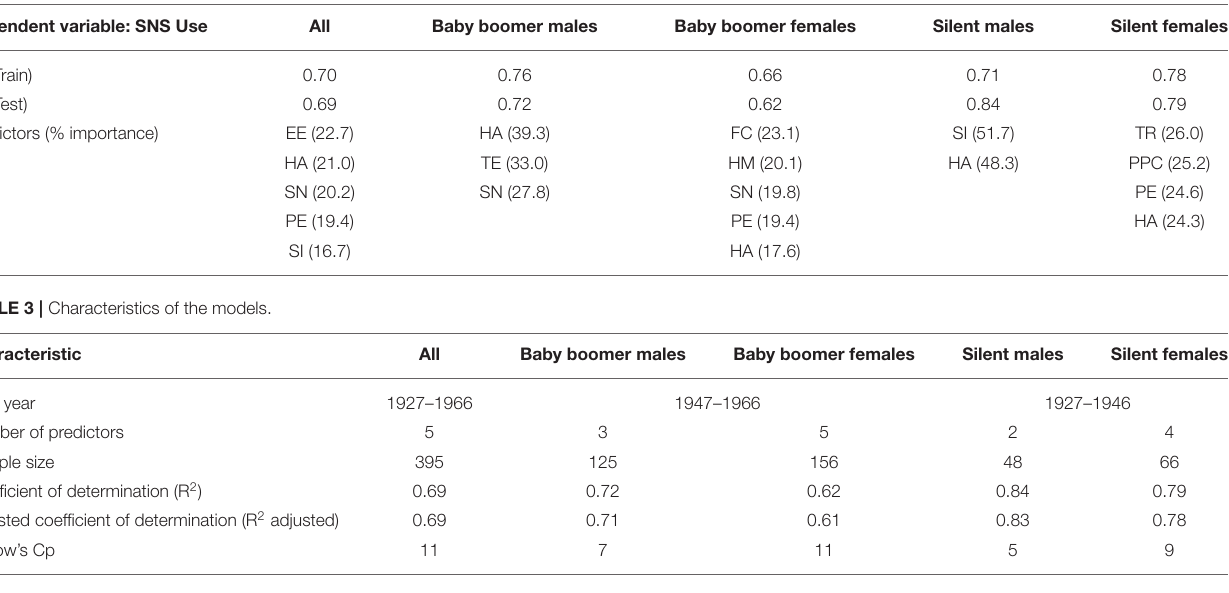
TABLE 2 | Predictors of SNS use.